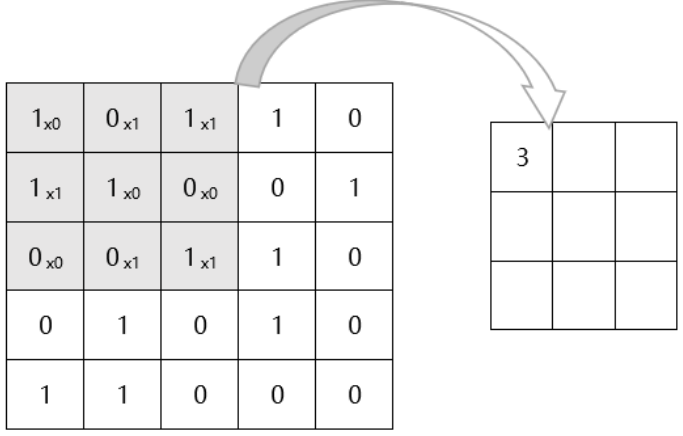
Figure 3. The concrete realization of the convolutional layer